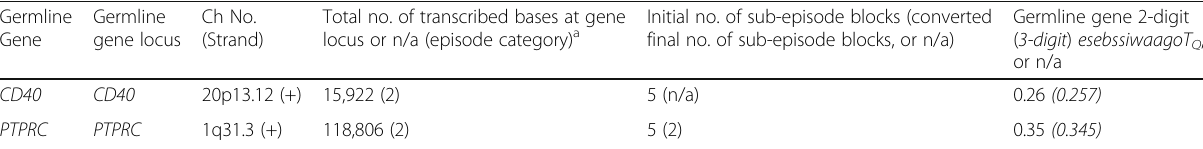
Table 5 Chromosome 20 (+) strand chromatin B-cell polarization receptor gene, CD40 , and chromosome 1 (+) strand chromatin B-cell polarization receptor gene, PTPRC , esebssiwaagoT Q > for pressuromodulation mapping of B-cell differentiation Germline Gene